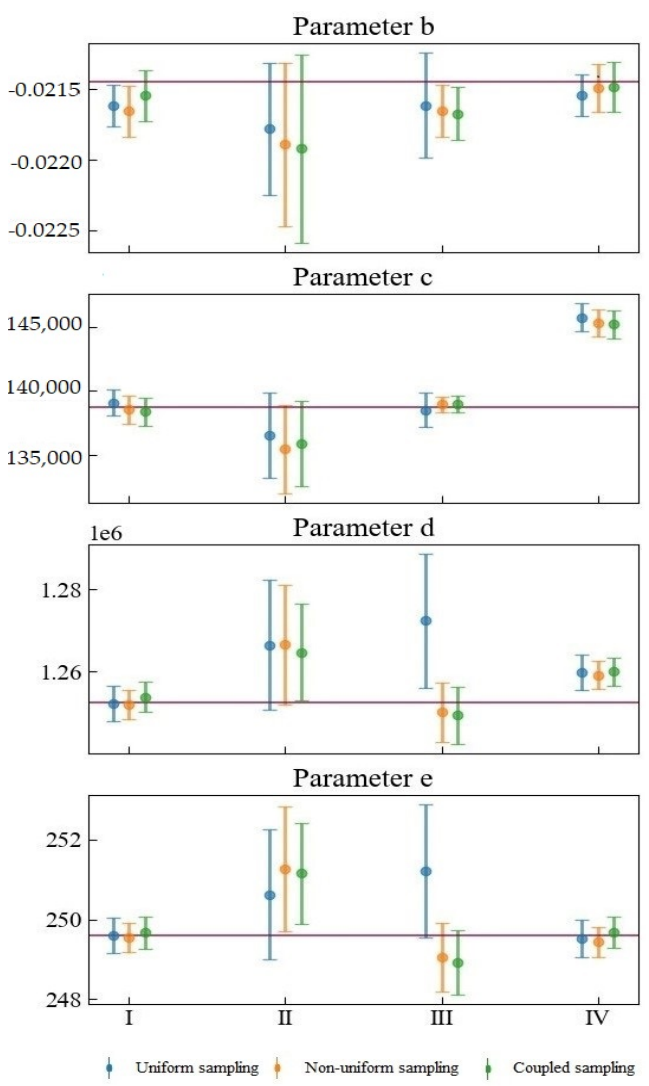
Figure 5. Fitting of the model parameters after substituting the simulated experimental data.